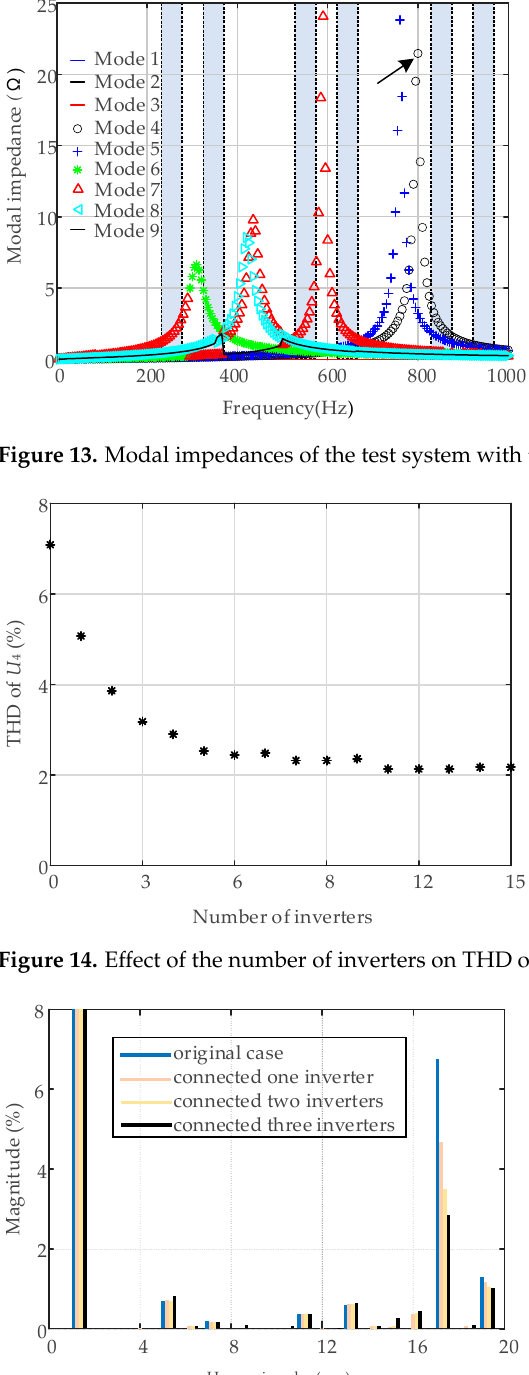
Figure 13. Modal impedances of the test system with three inverters on bus 4.